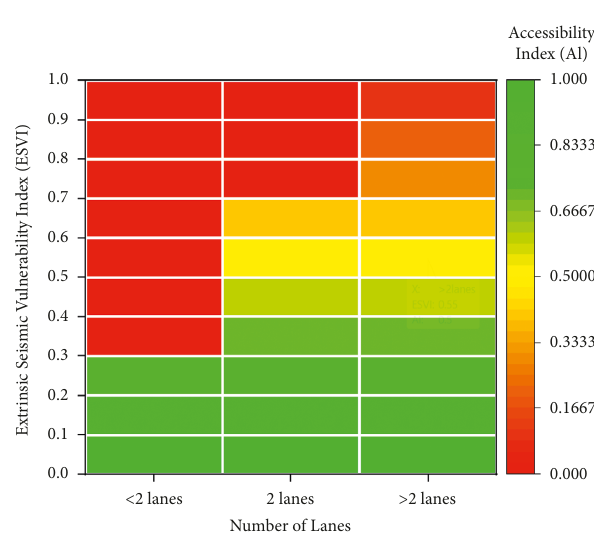
Figure 16: Integrated accessibility heat map between ISVI and resistance design of the road.